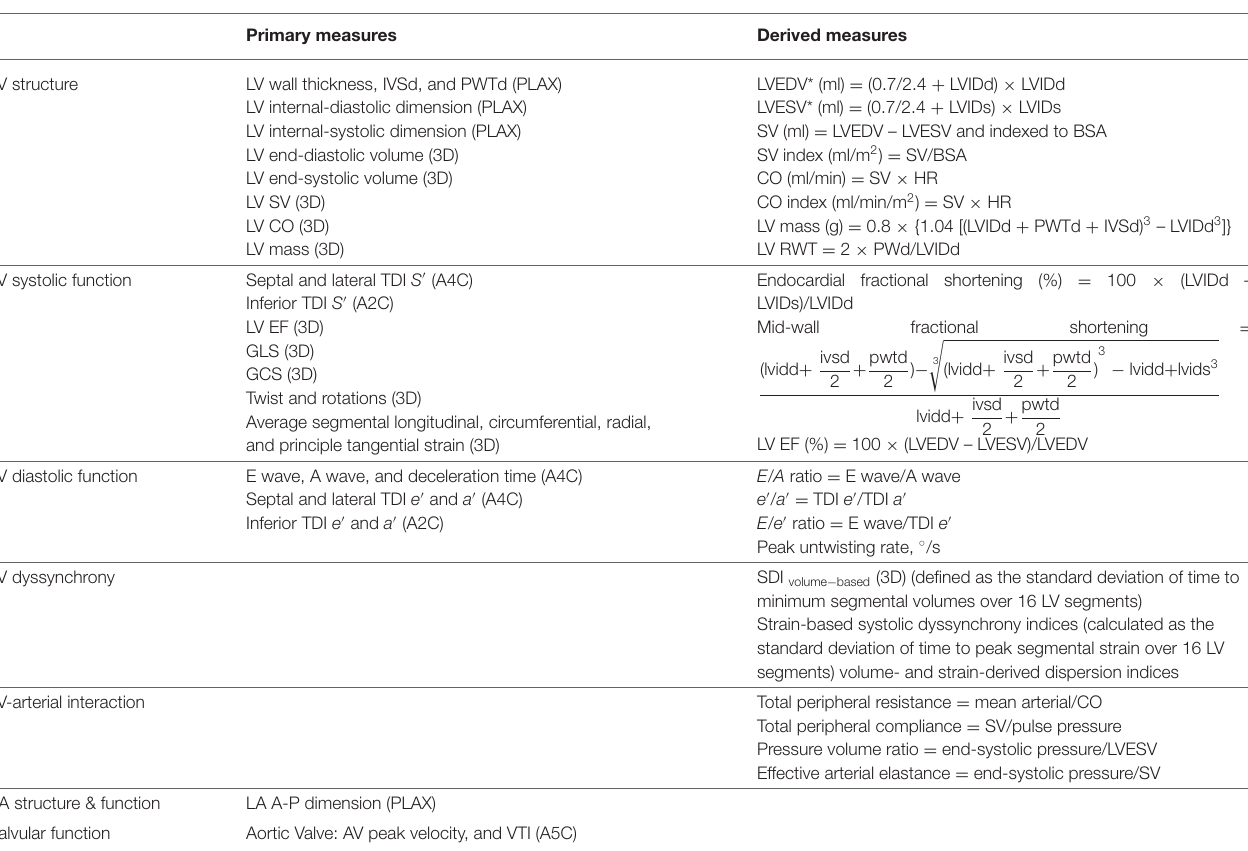
TABLE 2 | SABRE echocardiographic